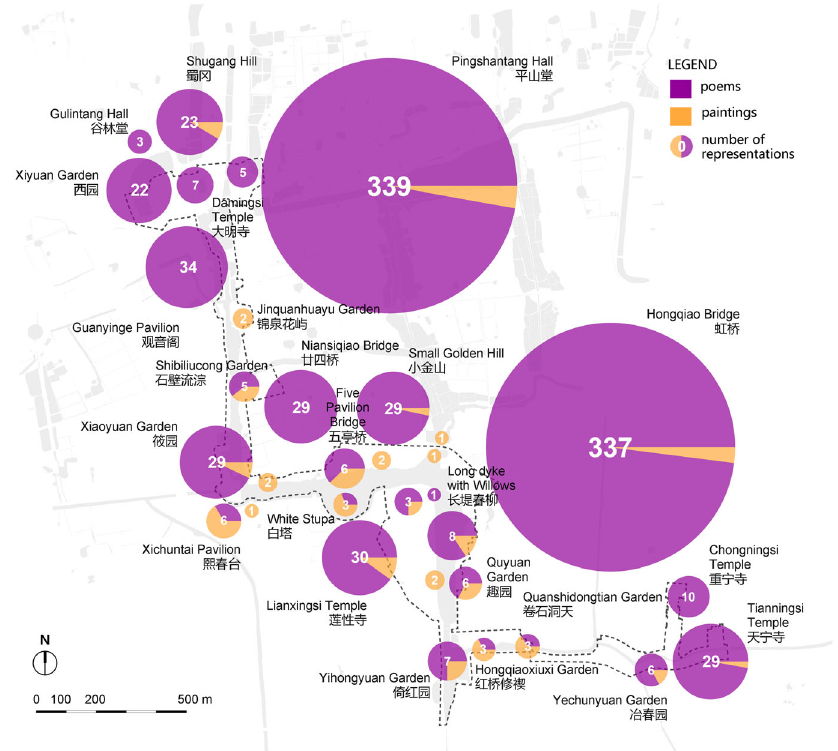
Fig. 6 The thematic map of landscape representation analysis for Slender West Lake between 1644 and 1911 (Source: the